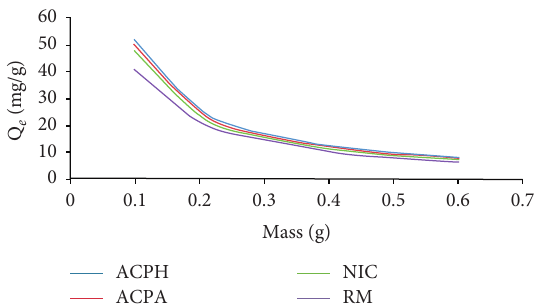
Figure 9: Effect of adsorbent mass on nickel(II) adsorption for ACPH, ACPA, NIC, and RM ( v � 20mL, t � 40 min, Co � 200mg/L, pH � 4, stirring velocity 150 rpm).